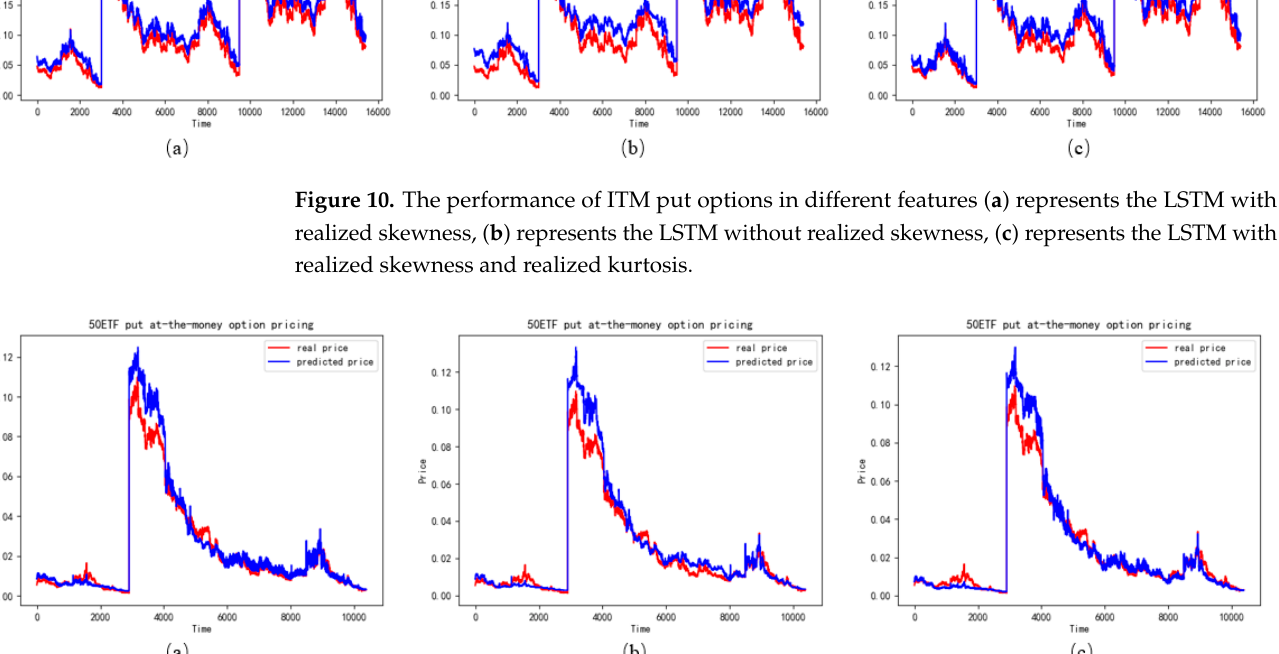
Figure 11. The performance of ATM put options in different features ( a ) represents the LSTM with realized skewness, ( b ) represents the LSTM without realized skewness, ( c ) represents the LSTM with realized skewness and realized kurtosis.